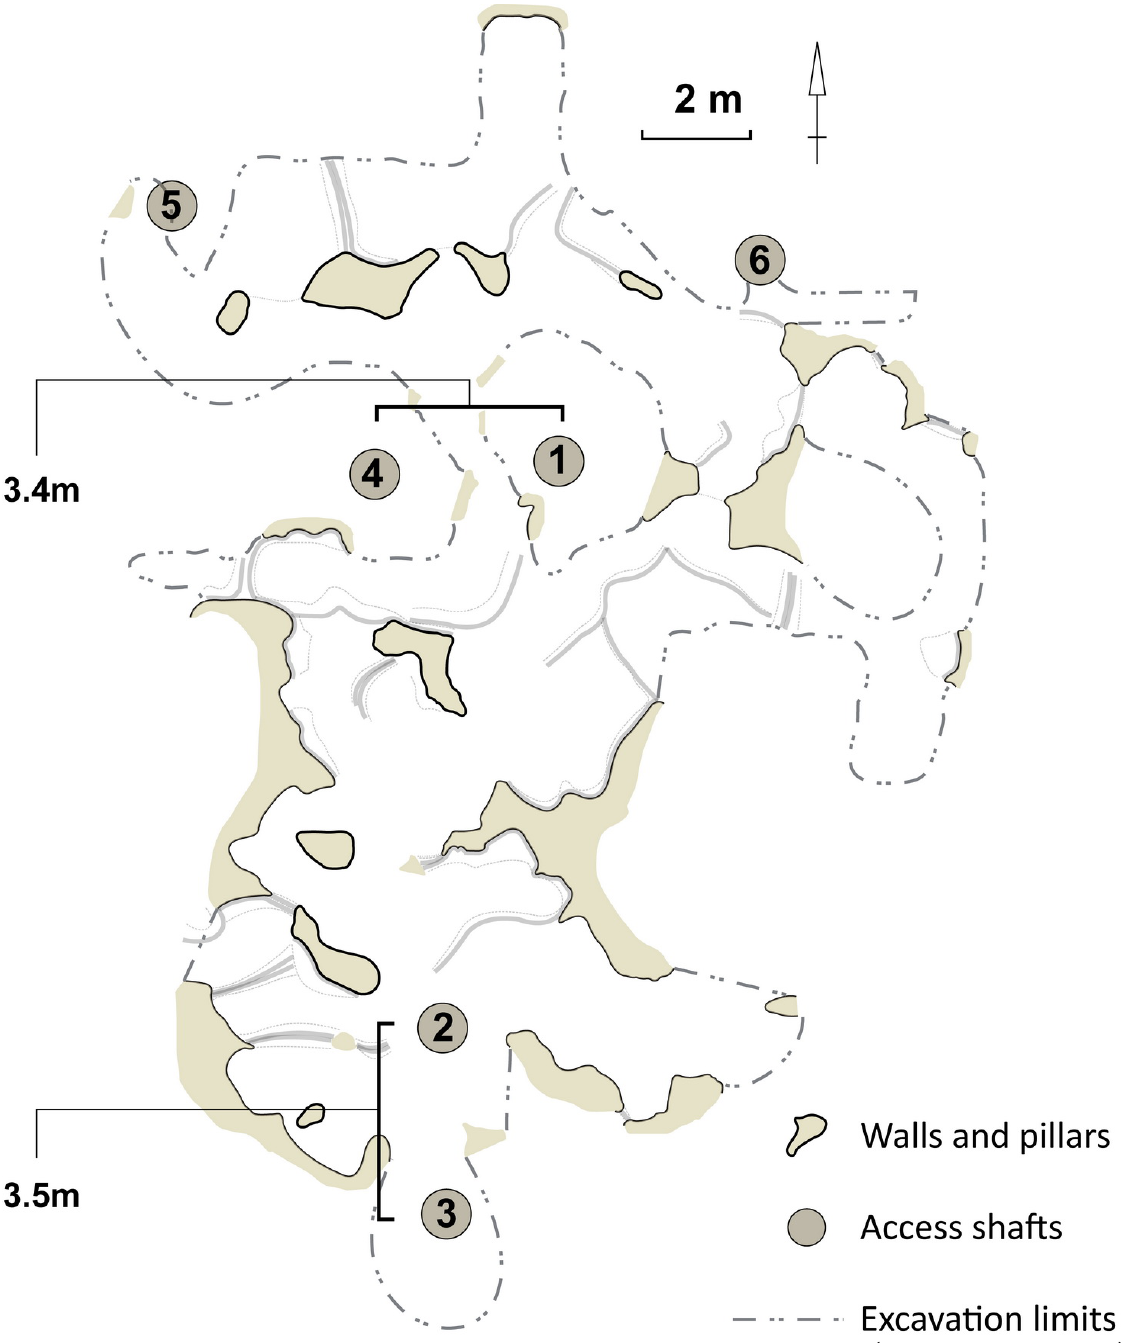
Figure 22. Spiennes, Camp-à-Cayaux. Underground map of the 16 m deep mines (excavations 1912-1914). Graphics by M. Woodbury after Hubert (1978),